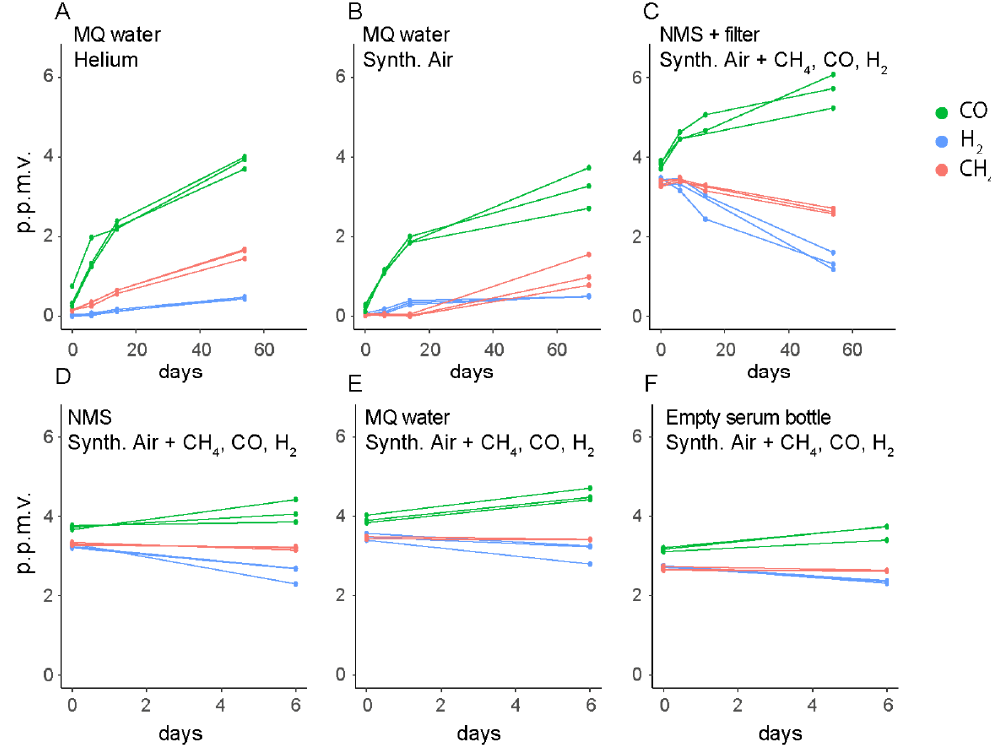
Figure 4. Gas leakage and other abiotic gas sources. ( A , B ) Long incubations of cell-free controls were performed to identify signs of CO and CH 4 leakage or release into or out of the bottles. ( C – F ) Short incubations of cell-free controls were considered sufficient to identify the same patterns of gas leakage and accumulation irrespective of bottle liquid and headspace composition. MQ: MilliQ. Synth. Air: Synthetic air. NMS: nitrate mineral salts. The multiple data points in each color represent different biological replicates from the same condition. Synthetic air contained less than 0.2 p.p.m.v. of CH 4 , CO and H 2 .